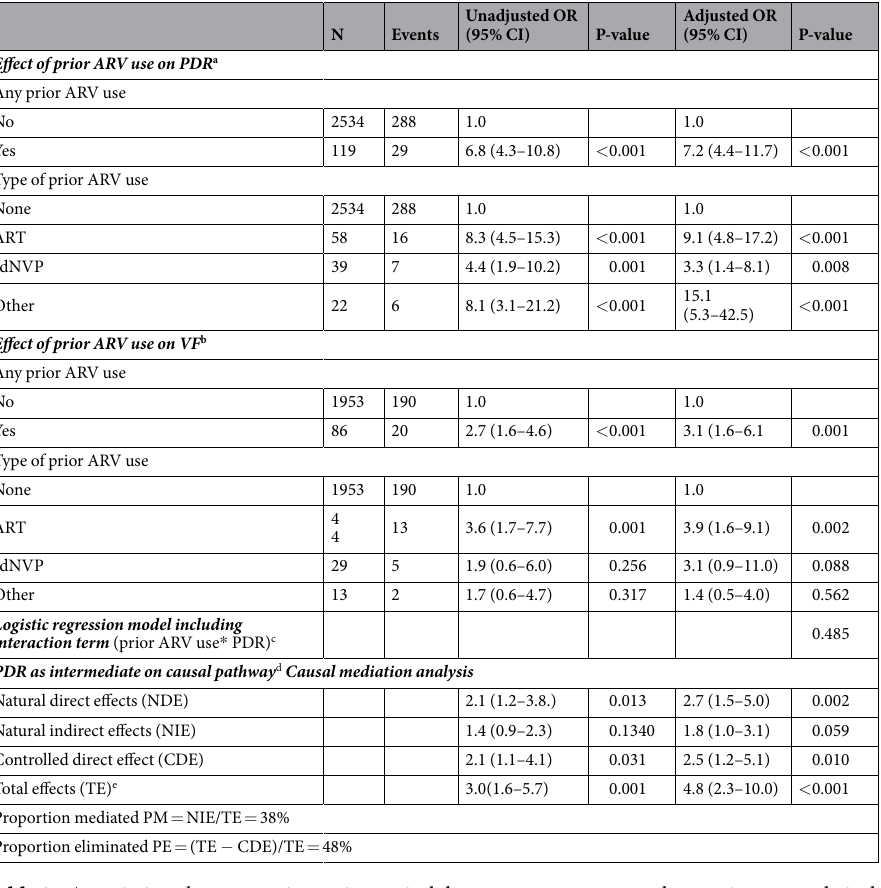
Table 2. Associations between prior antiretroviral drug use, pre-treatment drug resistance and virological failure. Abbreviations: ART, antiretroviral combination therapy; ARV, antiretroviral; PDR, pretreatment drug resistance; sdNVP, single-dose nevirapine for PMTCT; VF, virological failure’; NIE, natural indirect effects; NDE, natural direct effects; CDE, controlled direct effects; TE, total effects. a Adjusted for age, sex, pre-treatment CD4 count, pre-treatment viral load, WHO clinical stage, calendar year of ART initiation, country. b Adjusted for age, sex, pre-treatment CD4 count, pre-treatment drug resistance, type of ART, calendar year of ART initiation and adherence. c Adjusted for age, sex, pre-treatment CD4 count, type of ART, calendar year of ART initiation and adherence. d Adjusted for age, sex, pre-treatment CD4 counts, pre-treatment viral load, type of ART, calendar year of ART initiation and adherence. e odds ratio for TE i.e. OR TE = OR NDE * OR NIE